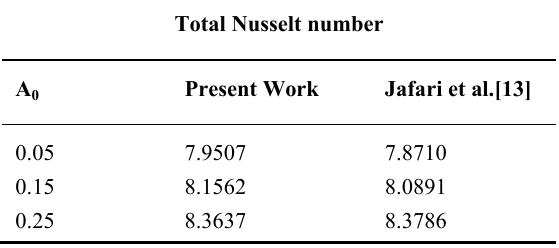
Fig. 3. horizontal velocity for mesh indepency investigation at Re=100 and 0.02 φ = in steady State.